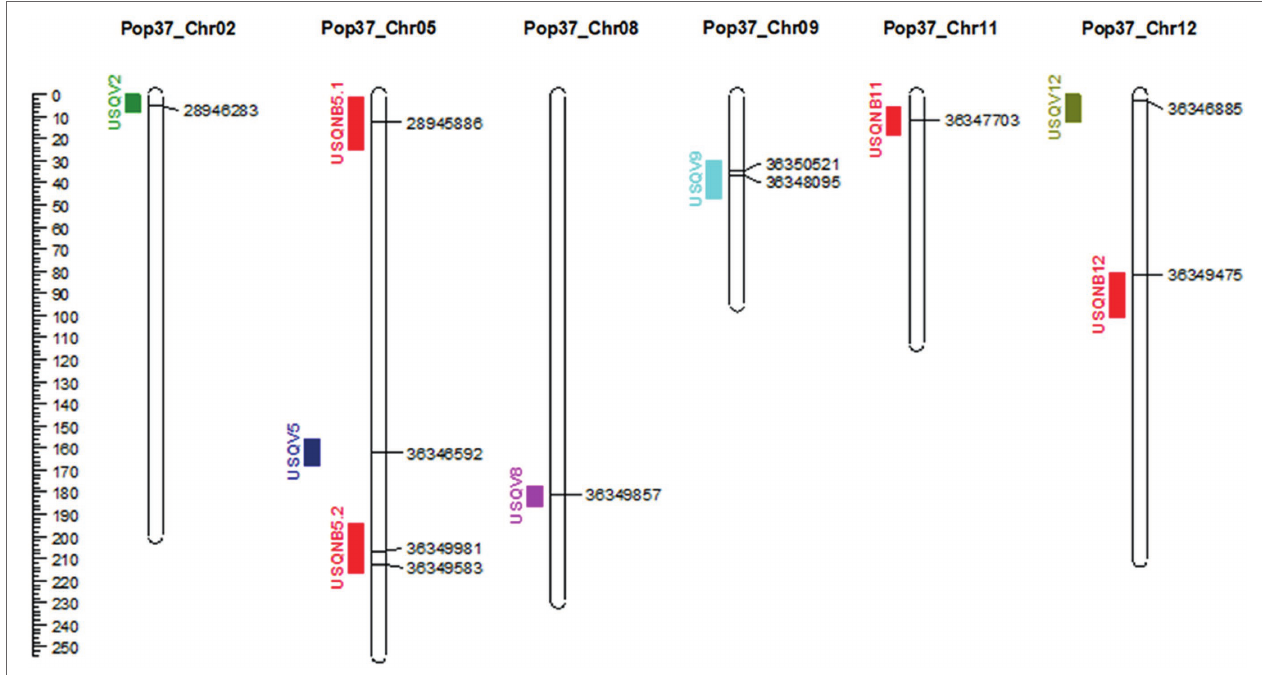
FIGURE 3 | Genetic map of Pop37 ( Ptt -NB63 × Ptm -HRS07033) showing identified QTL on the left of the chromosome and markers at the peak of the QTL on the right. Distance in cM is indicated on the